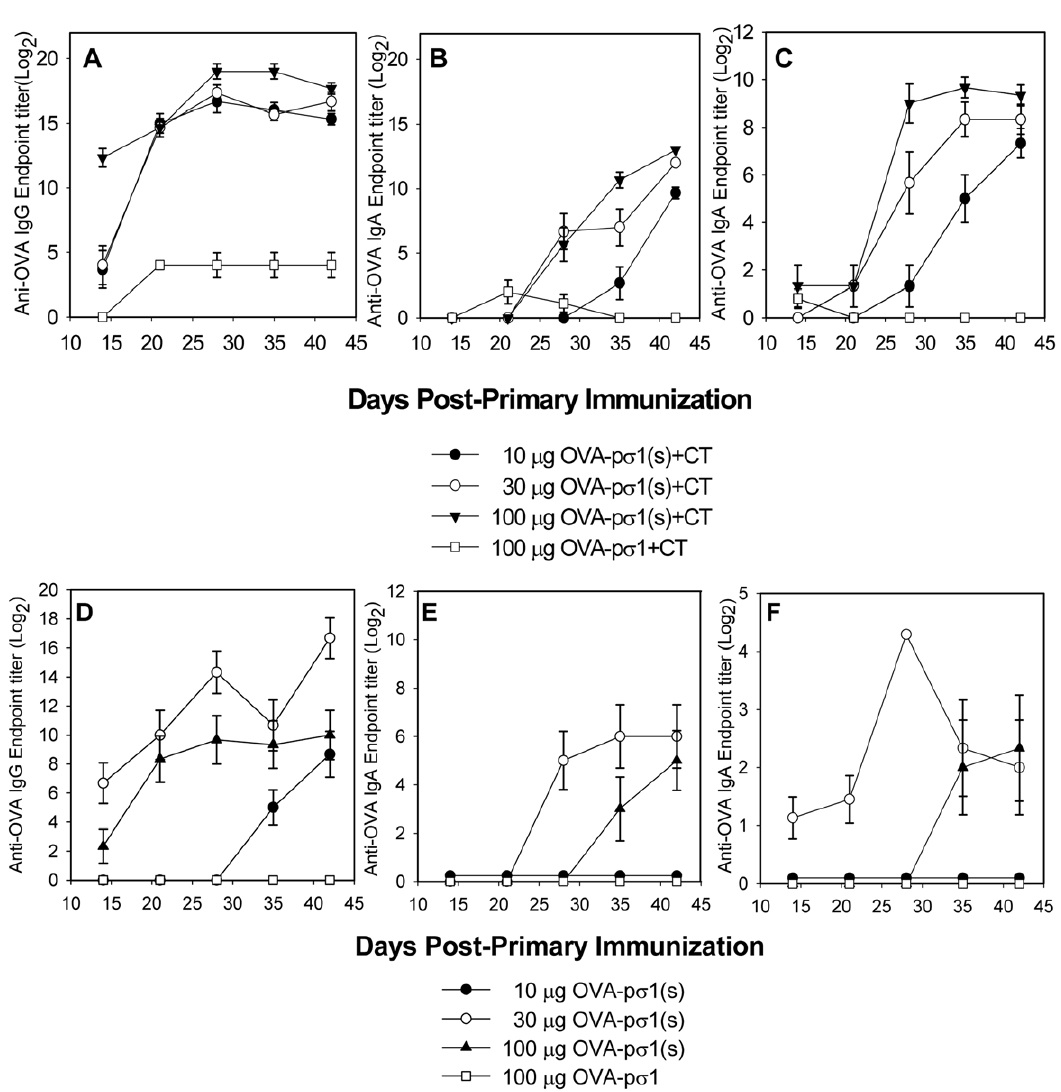
Figure 4. Nasal OVA-p s 1(s) stimulates Ab responses, unlike OVA-p s 1. C57BL/6 mice were nasally vaccinated with OVA-p s 1(s) or OVA-p s 1 plus A.–C. adjuvant or D.–F. without adjuvant, and OVA-specific A. and D. serum IgG, B. and E. serum IgA, and C. and F. fecal IgA Ab responses were measured. C57BL/6 mice (5/group) were dosed nasally with 10, 30, or 100 m g OVA-p s 1(s) or with 100 m g OVA-p s 1 with or without CT on days 0, 7, and 14. A kinetic analysis of the indicated time points is depicted as endpoint Ab titers from one of three experiments as mean 6 SEM.